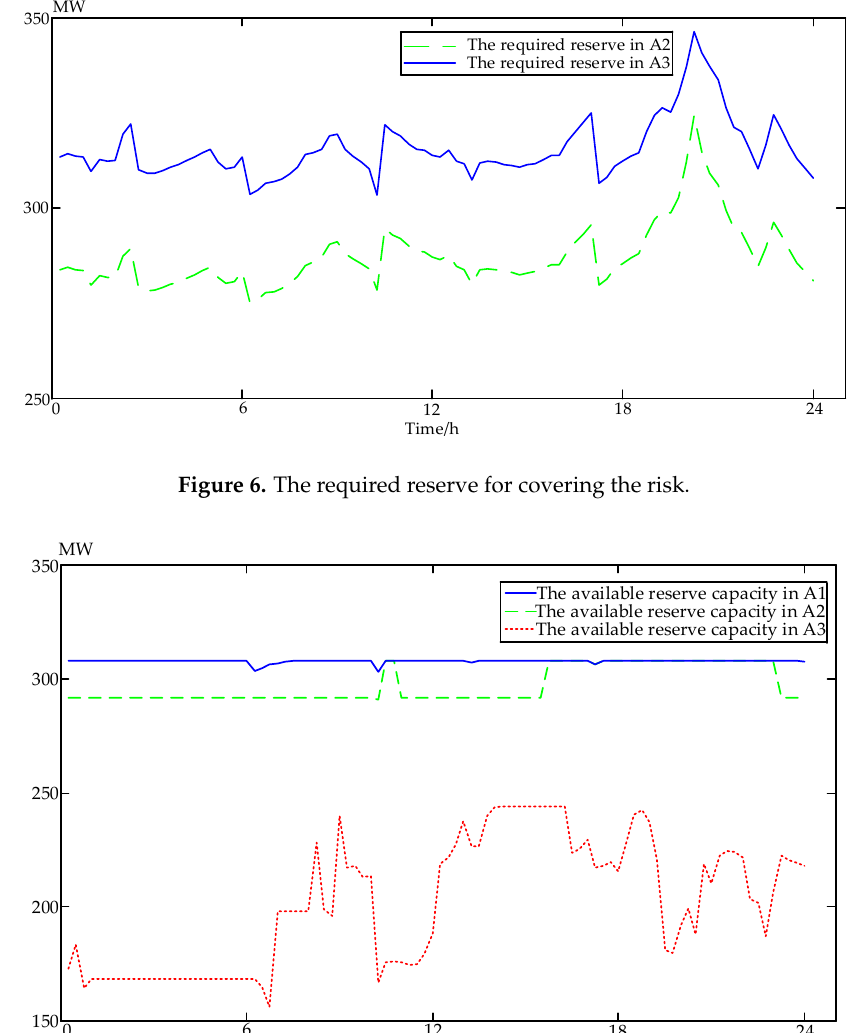
12 of 18 Figure 5. The power output of generation. 5.1. Risk Criterions Analysis In order to explore the impact of the risk measure on the UC scheduling, we compare three cases in the test and analyze the corresponding available reserve capacities: A1: the one-stage UC model is established to optimize the operation cost without the reliability requirements. The objective function of the UC model is modeled according to the Equation (24). A2: the three-stage UC model is established, by which the VaR is determined as the risk measure of the UC model. The objective functions of the first stage and second stage in Section 4.3 are replaced